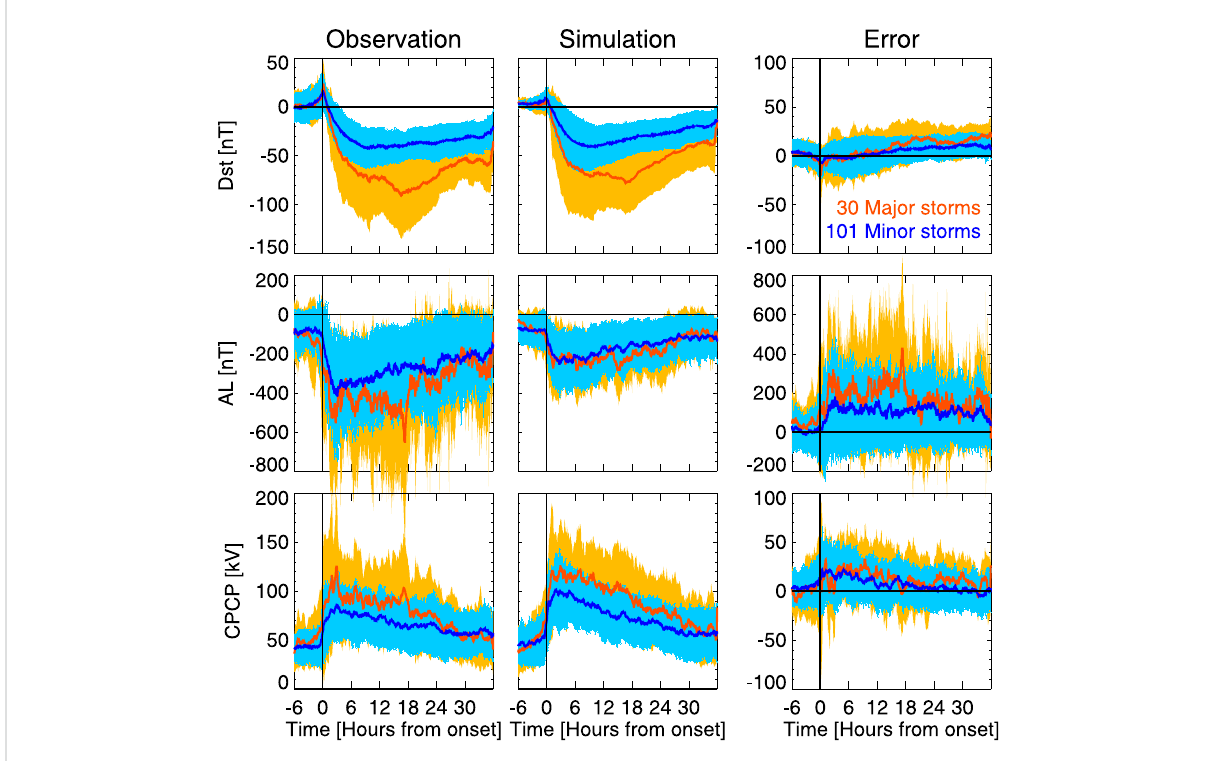
FIGURE 5 (Toprow)Dst;(Middlerow)AL;and(Bottomrow)CPCPfrom(Leftcolumn)Observations;(Middlecolumn)Simulation;and(Rightcolumn)Error (simulation – observation) for minor (blue, peak Dst > − 100 nT) and major (red, peak Dst < − 100 nT) storms. The thick solid lines show the superposed epoch curve (1-min temporal resolution), the shadings indicate the standard